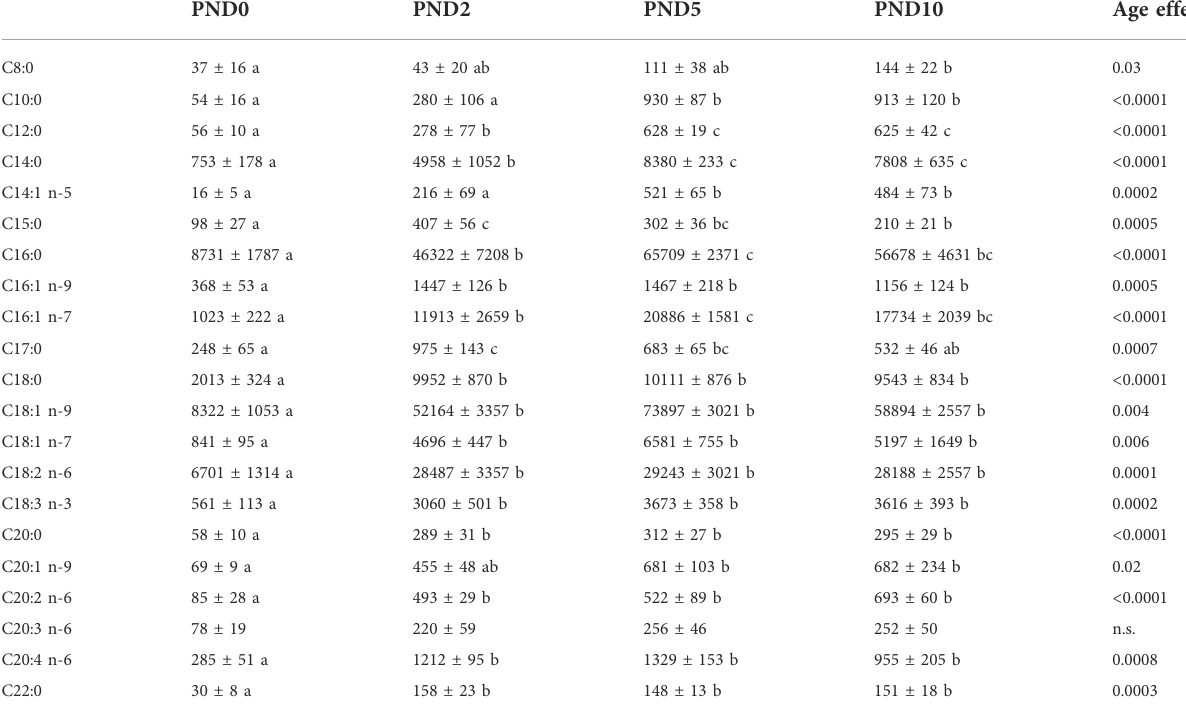
TABLE 3 Fatty acid composition (µg/g) of gastric content of suckled piglets. PND0 PND2